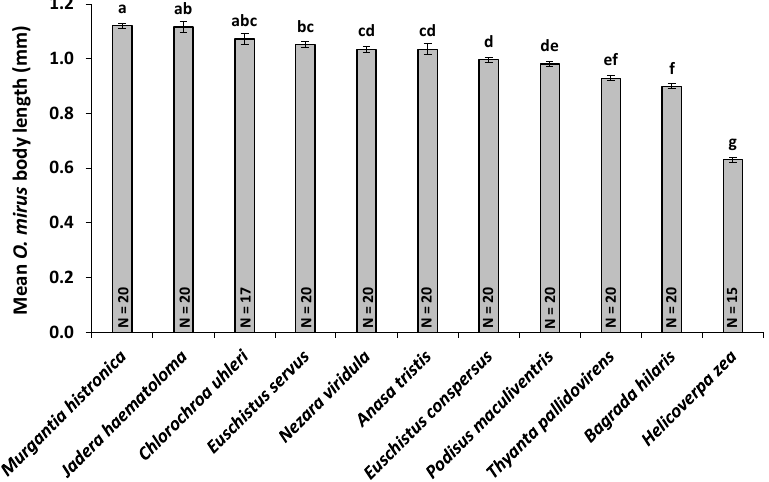
Figure 3. Comparison of mean ( ± SE) body length of Ooencyrtus mirus reared on the respective host eggs. N is the number of replicates. Significant differences are represented by different letters (Dunn’s Kruskal–Wallis multiple comparison, p <